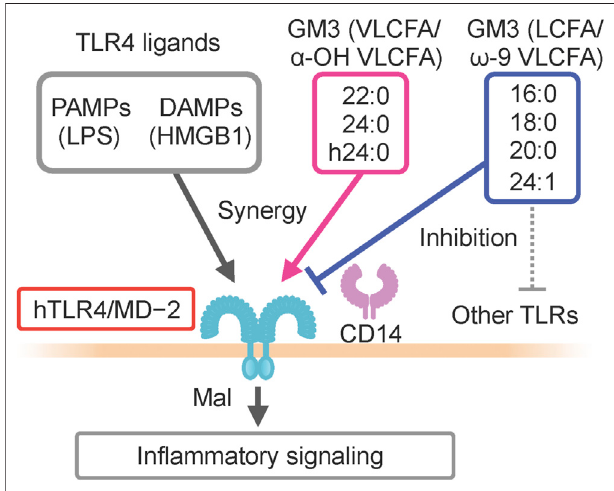
FIGURE 3 | Pro- and anti-in fl ammatory GM3 molecular species against human TLR4/MD2